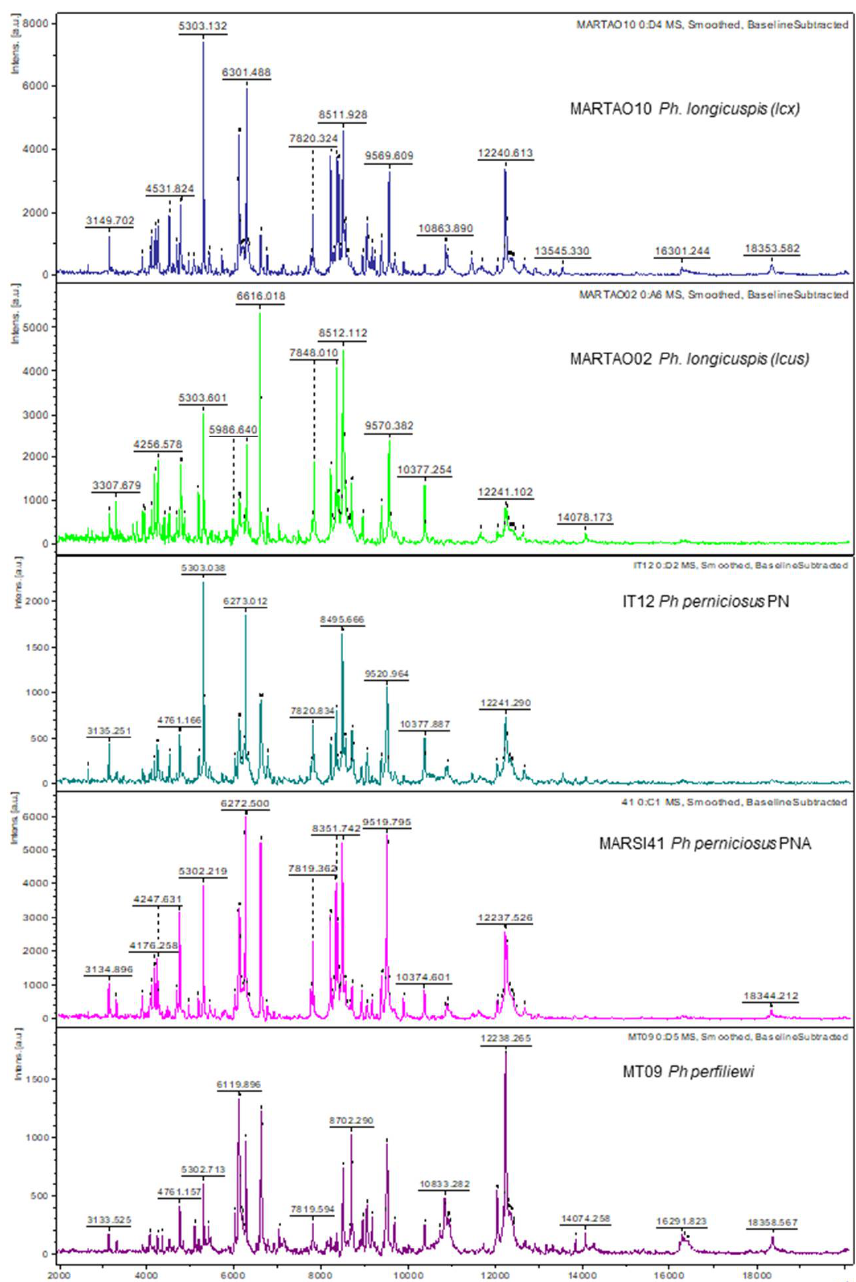
Figure 2. Representative spectra of Ph. longicuspis (lcus haplotype), Ph. longicuspis (lcx haplotype), Ph. perniciosus PN (typical form), Ph. perniciosus PNA (atypical form) and Ph. perfiliewi .